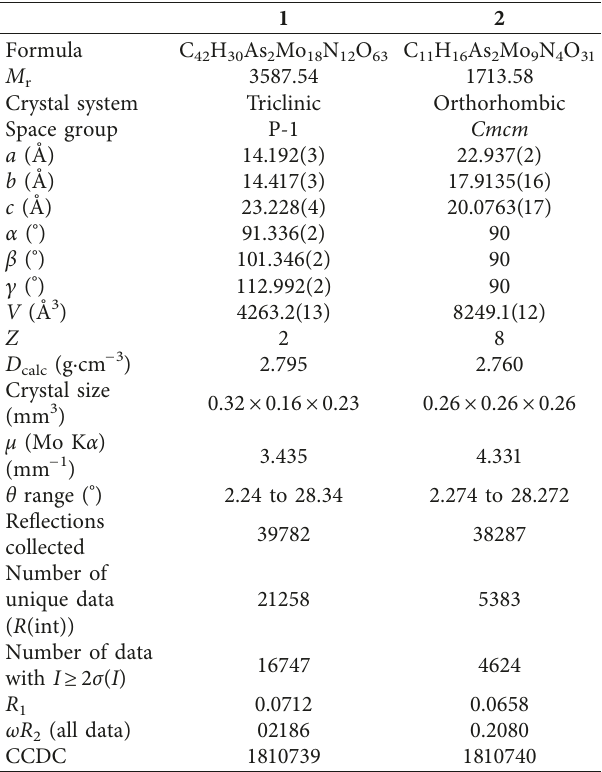
Table 1: Crystal data and structure refinements for compounds 1 and 2